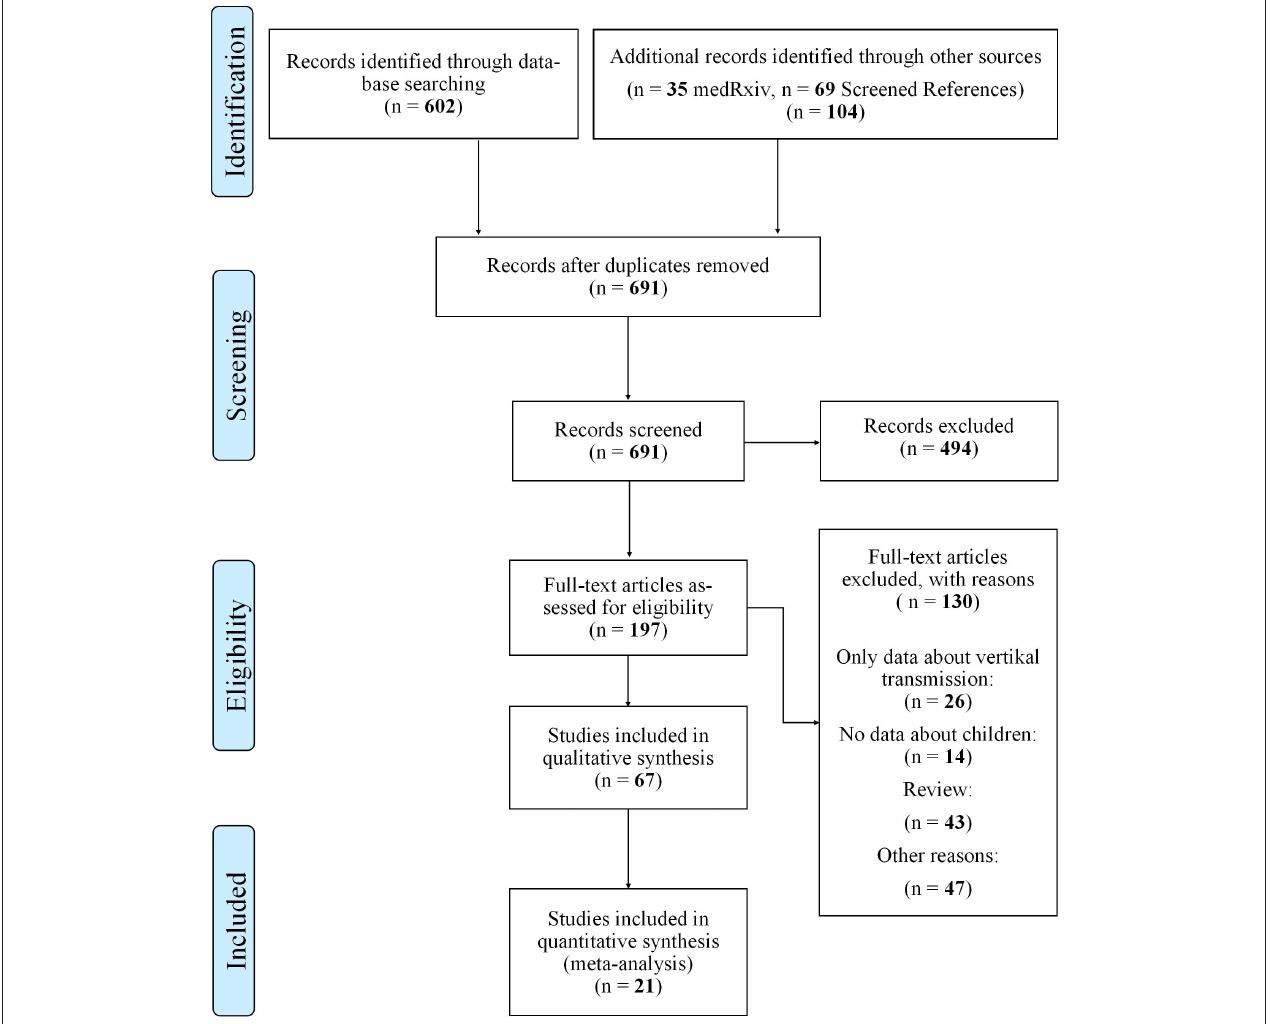
FIGURE 1 | PRISMA flow diagram for